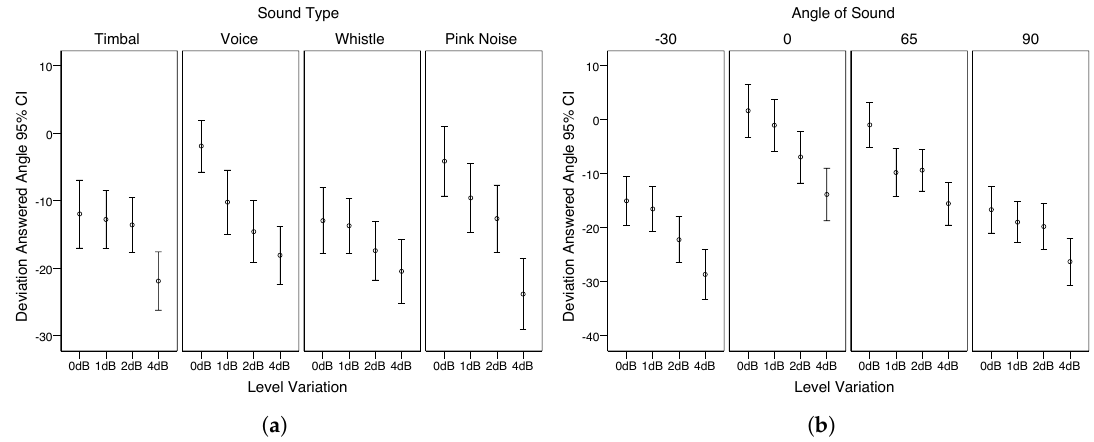
Figure 6. Average deviation of the answered angles (degrees) versus the level variation (dB): ( a ) considering the type of sound; ( b ) considering the angle reproduction of